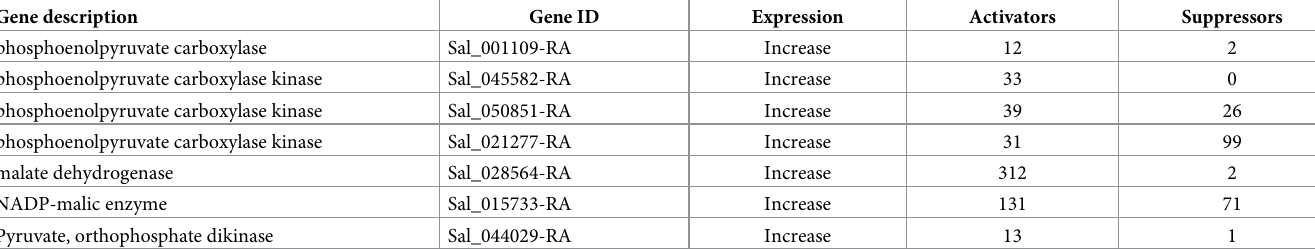
Table 3. Summary of gene interactions in the core CAM genes during C3-CAM